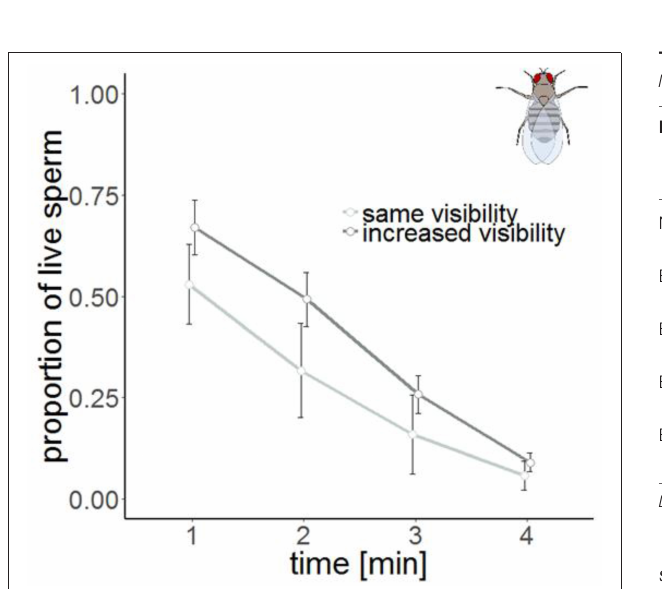
FIGURE 4 | Sperm number at the four different points in time for the time series experiment in Cimex lectularius ( A , n = 10) and in Drosophila melanogaster ( B , n = 10). Bars show mean ± s.e.